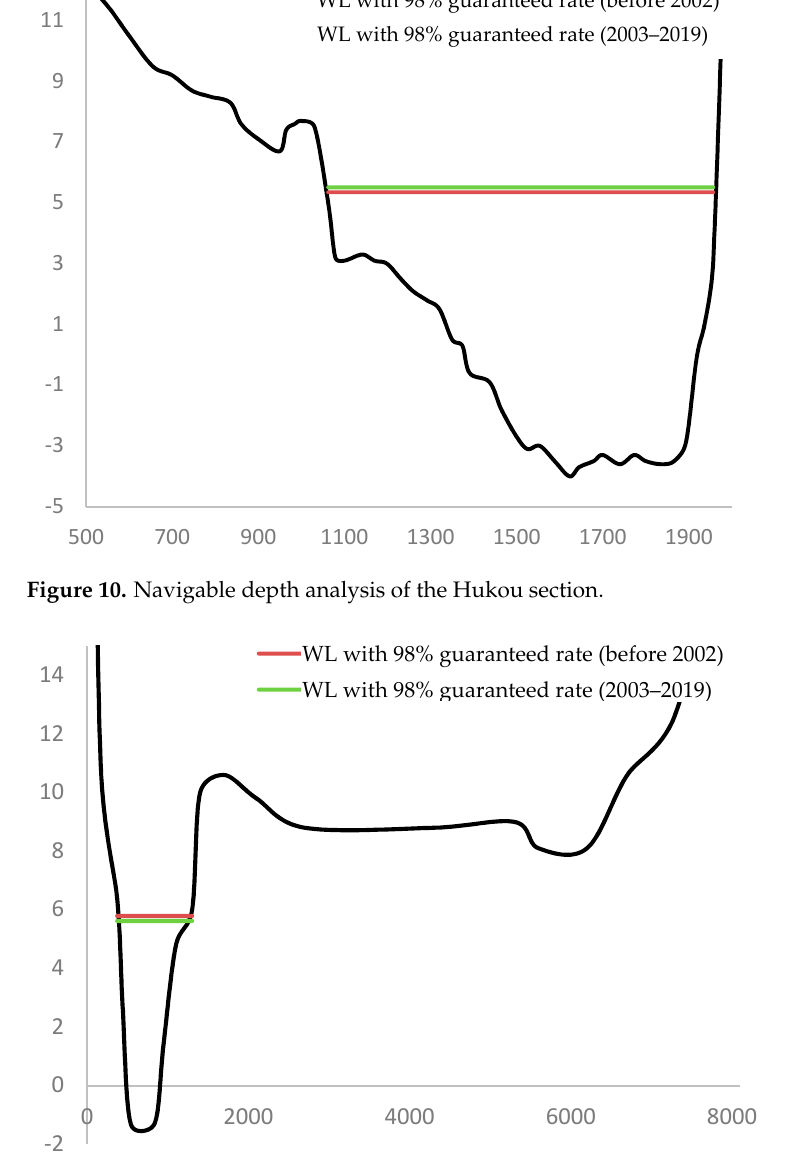
Figure 11. Navigable depth analysis of the Xingzi section.